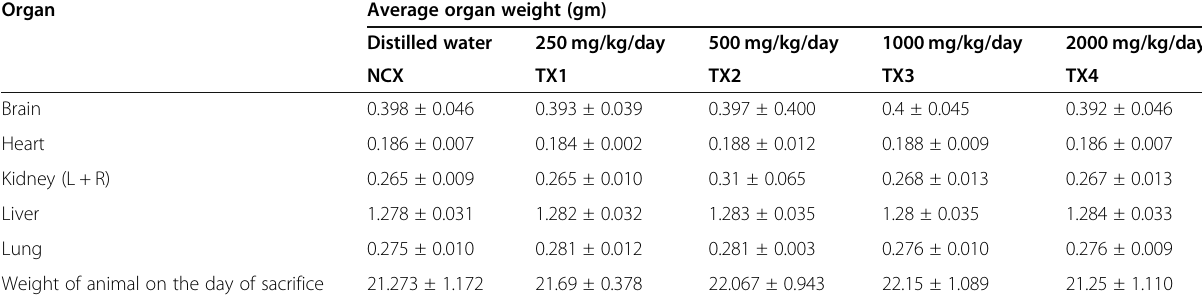
Table 3 Effect of polyherbal combination (PHC) on average organ weight (g) of mice